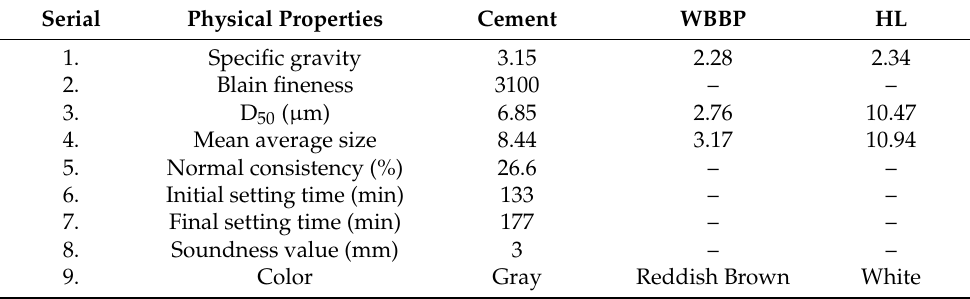
Table 3. Physical properties of cement, waste burnt brick powder (WBBP), and hydrated lime